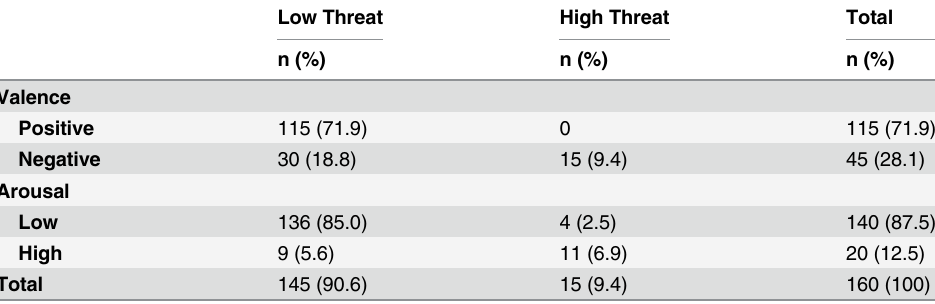
Table 4. Threat by Valence and Arousal Groups (total number of words =